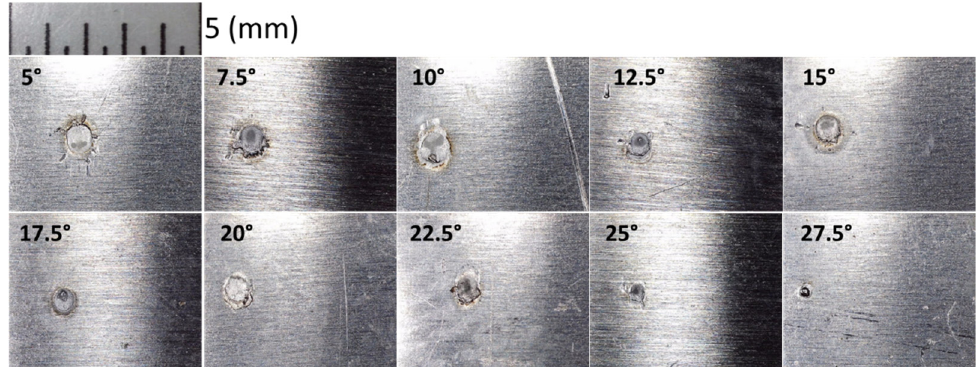
Figure 5. Welding traces the C surface (welding surface of 0.8 mm thick sheet) for different welding torch angles, θ (70.43 Joules).